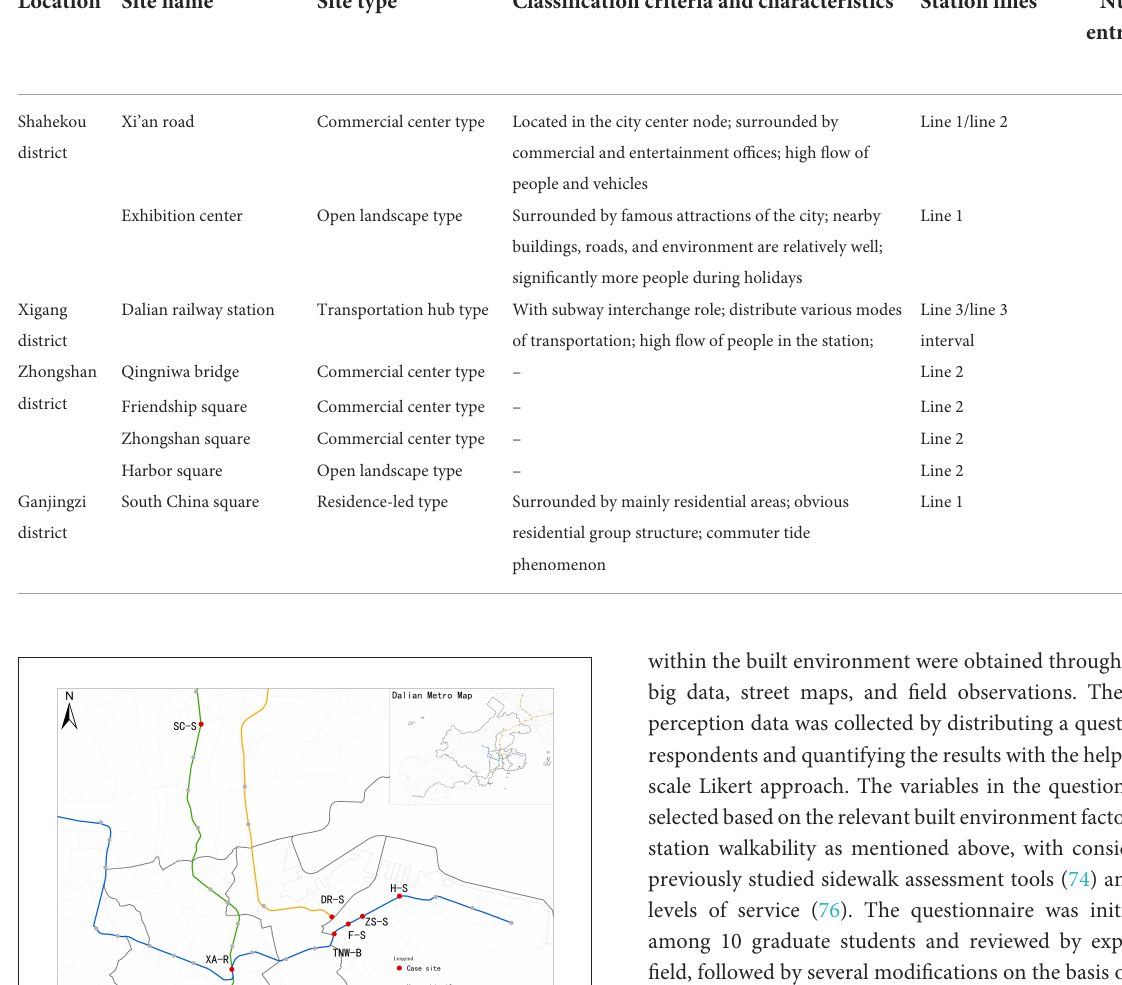
TABLE 1 Overview of research sites.